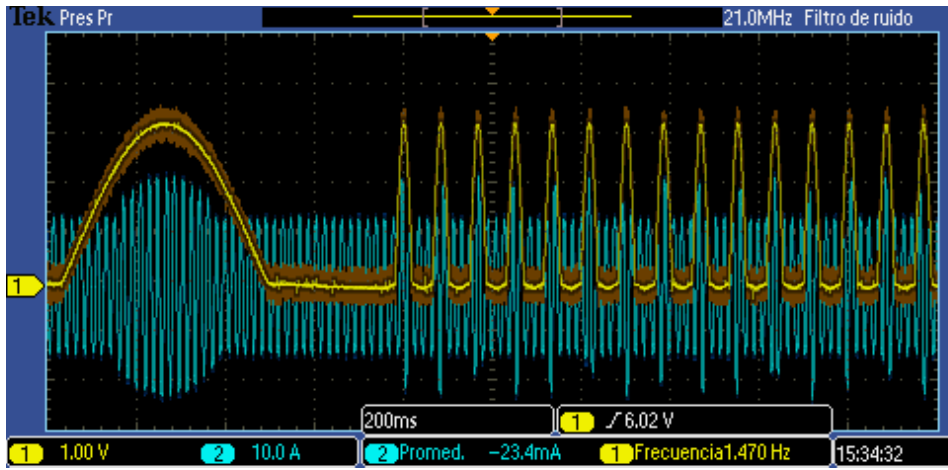
Figure 24. Motor current behavior after a sudden change in the pedaling frequency: 1 to 12 Hz.